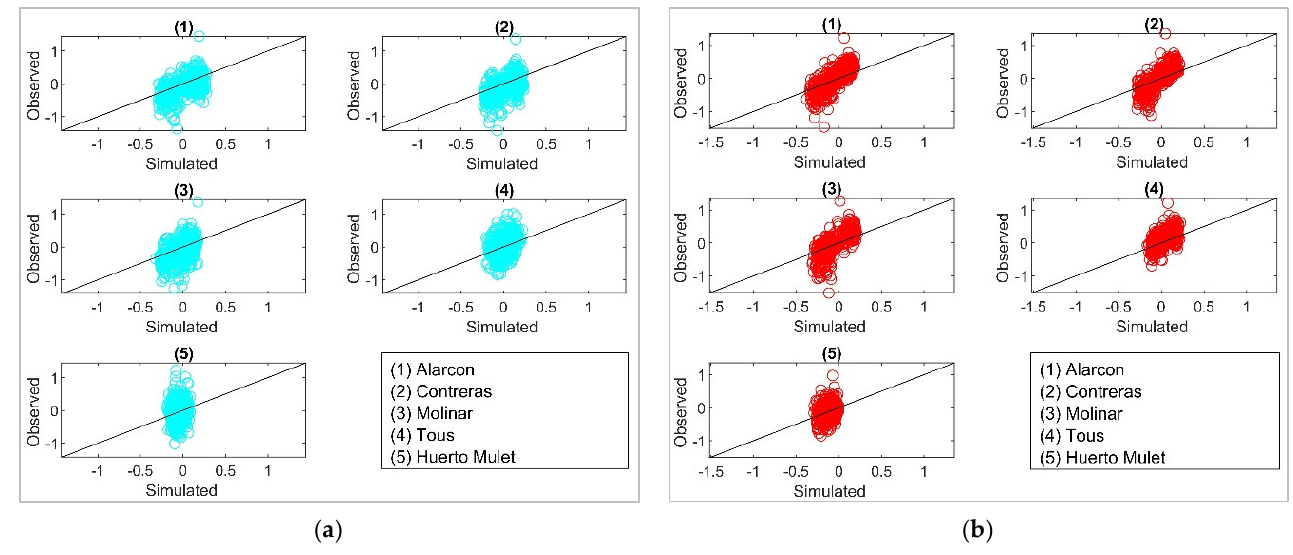
Figure 11. Scatter plots for observed skewness coefficient versus generated (mean 66 years observed and 1000 simulated series) for two models: ( a ) maximum temperature for each calendar day (blue) and ( b ) temperature range for each calendar day (red).